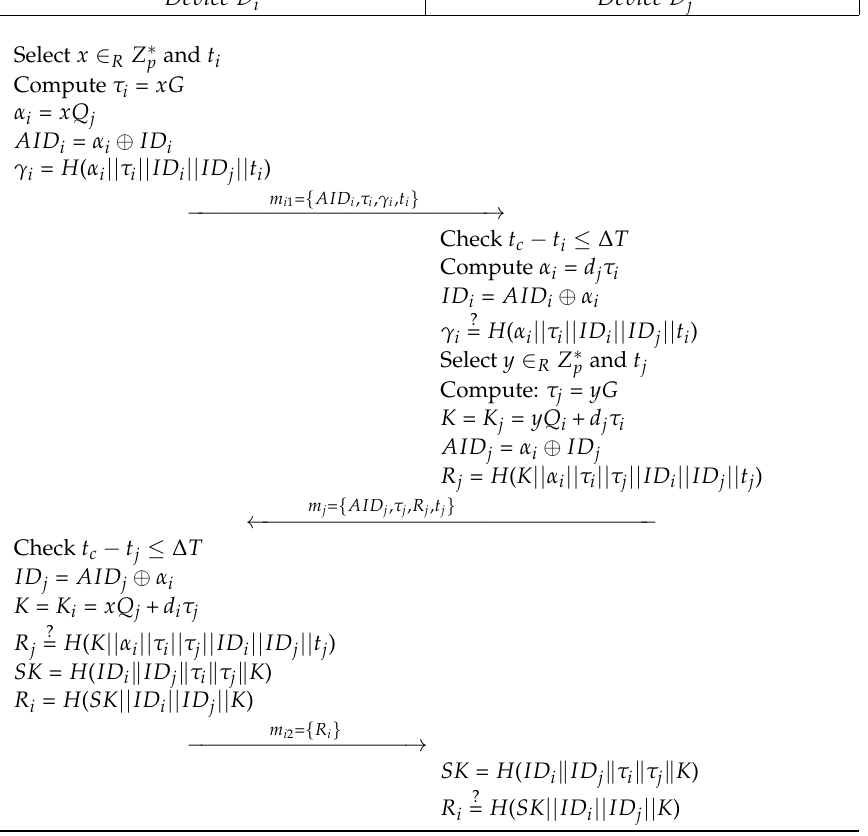
Figure 5. Proposed key agreement.